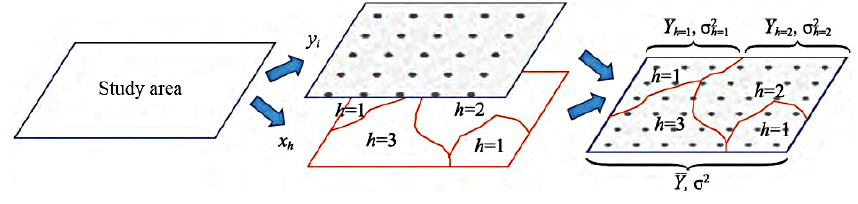
Figure 4. Principle of geodetector.